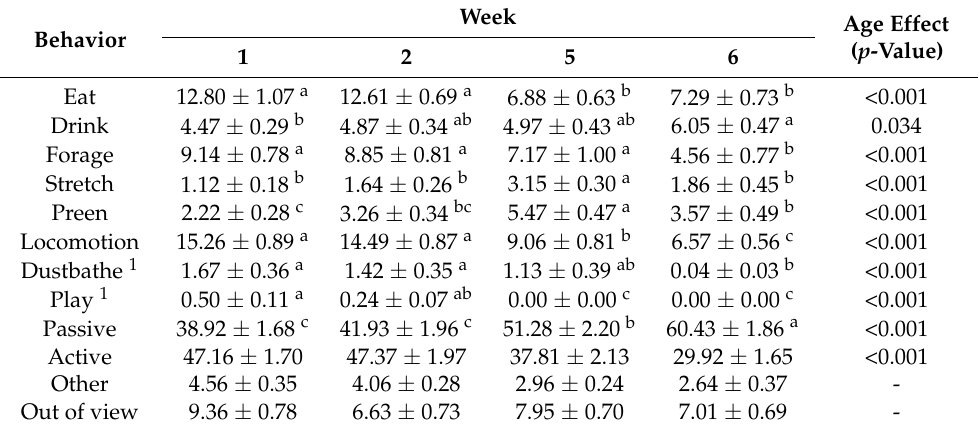
Figure 2. Percentage of observations (mean % ± SEM) spent on eating, drinking, foraging, stretching, preening, locomotion, dustbathing, play, passive, and active behaviors by bird age (in weeks) and by treatments group, with negative control (NEG), iodine mat (MAT), iodine mat with slatted floor (SLAT), and clean litter (POS) provided either from day 1 of age or 29 of age. Within week means without a common superscript ( a – d ) differed at p < 0.05. Table 2. Behaviors as percentage of observations at pen-level (mean % ± SE) during week 1, 2, 5 and 6 of